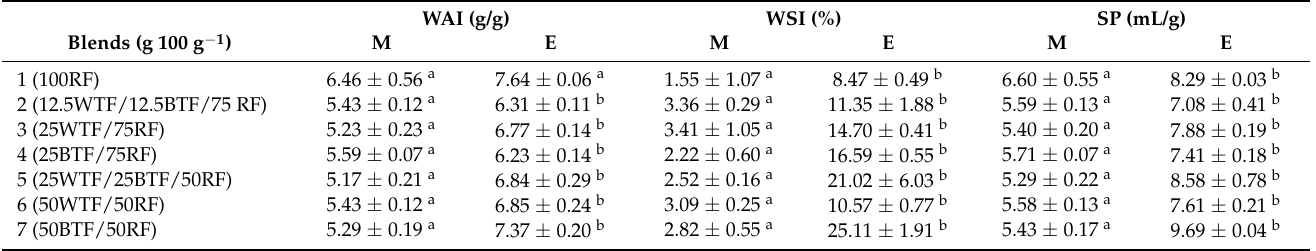
Table 4. Hydration properties of flours expressed as water absorption index (WAI), water solubility index (WSI) and swelling power